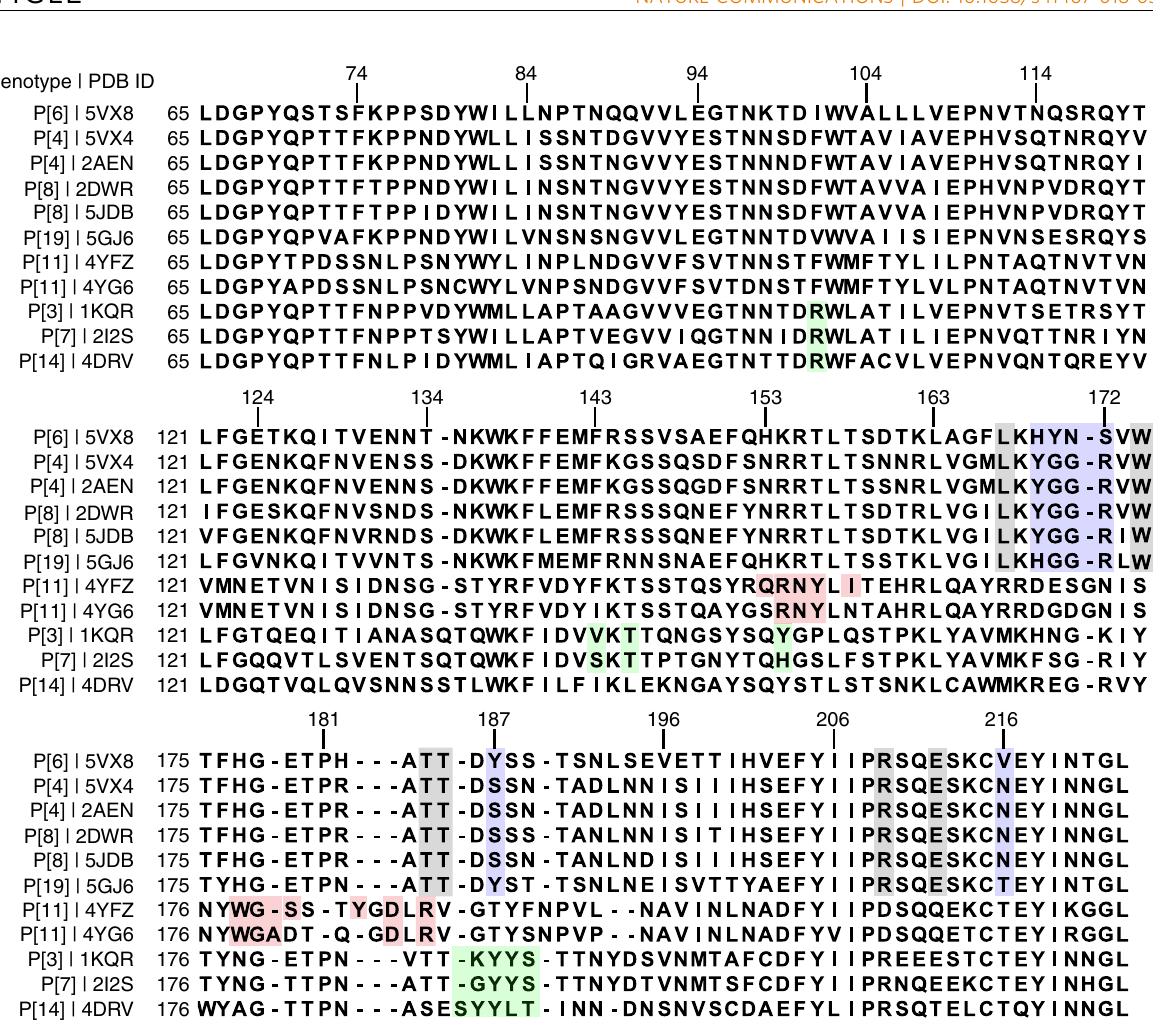
Fig. 4 Structure-based sequence alignment of VP8*s in Chimera. The residues known to bind glycans are indicated with colored shade. The glycan binding amino acids that are conserved or non-conserved in the prevalent strains (P[6], P[4], P[8], and P[19]) are denoted with black and blue shades, respectively. The precursor glycan binding sites in P[11] RVs are labeled with light red shade. The A-type HBGA binding site in P[14] RV, and the sialic acid binding residues in P[3] and P[7] RVs are denoted with green shade. The PDB IDs for each structure are shown by the